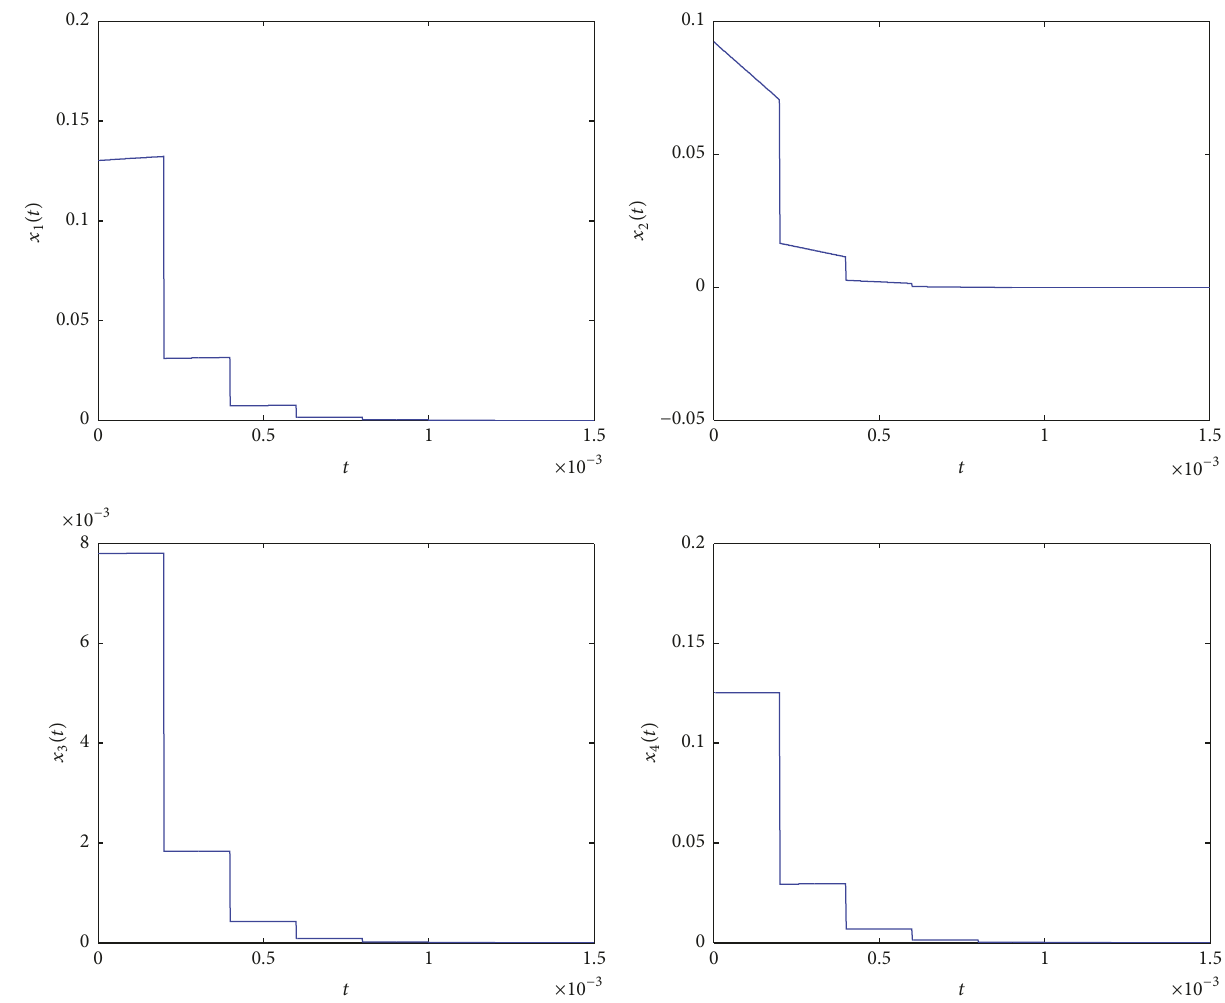
Figure 2: The state trajectory of the controlled memristor based chaotic